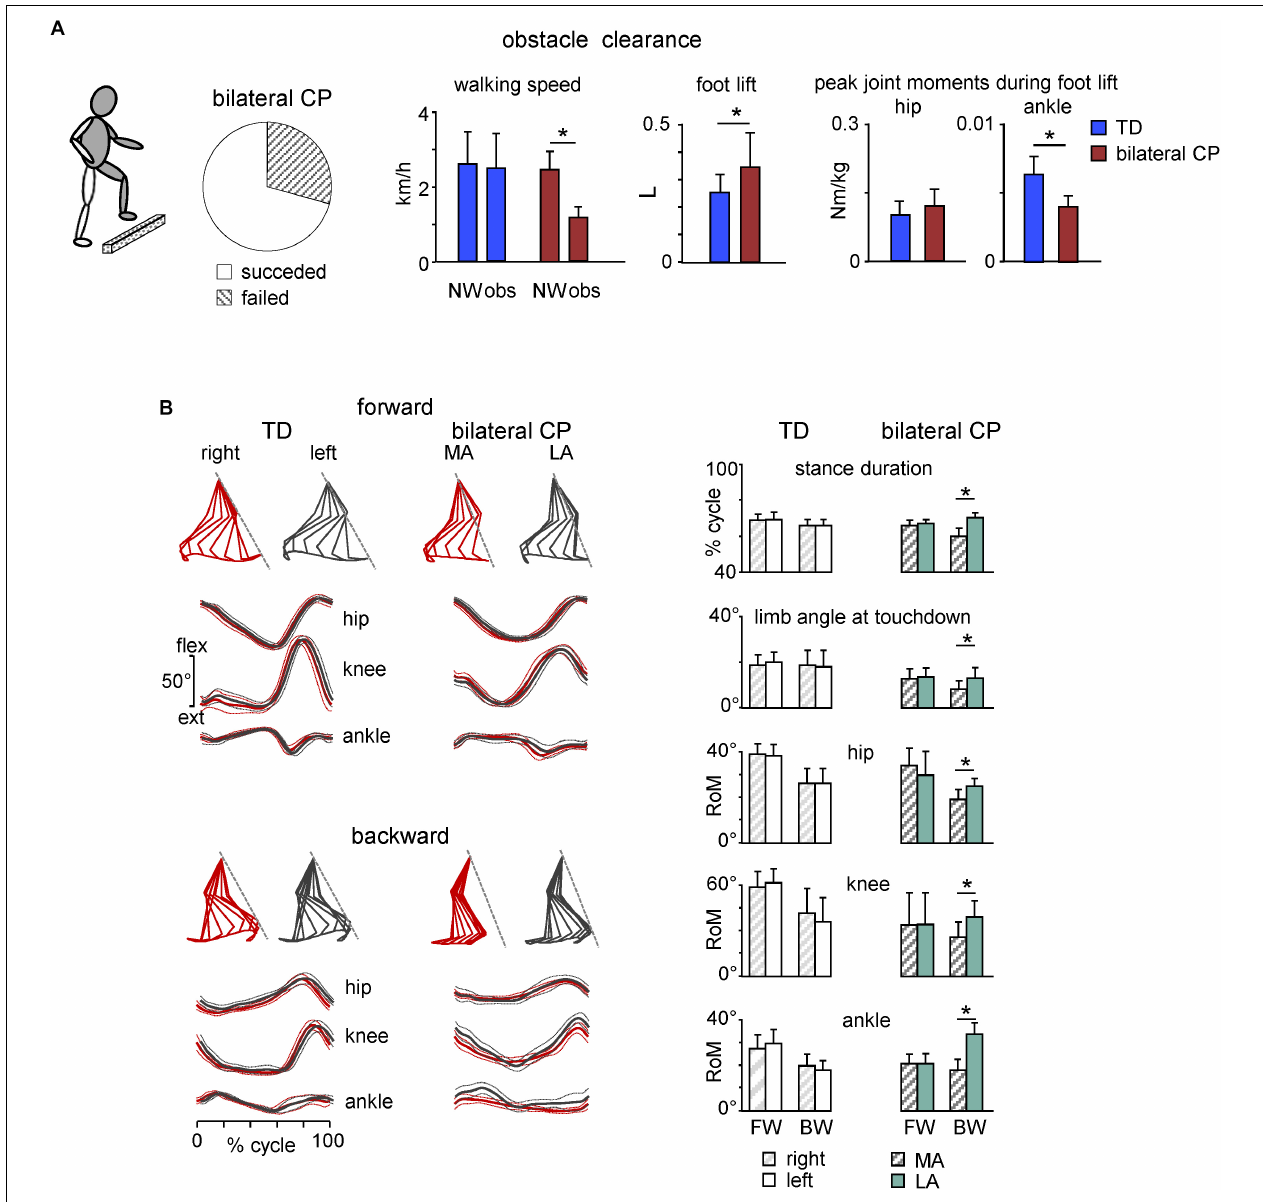
FIGURE 5 | Adaptive locomotion in children with CP. (A) Obstacle task performance in children with bilateral CP. From left to right: pie chart showing the percentage of trials for children with succeeded and failed obstacle clearance, mean (+SD) walking speed for successful trials, foot lift and flexor peak hip and ankle muscle moments during trailing limb elevation. Asterisks denote significant side differences. Adapted from Cappellini et al. (2020). (B) Kinematics of forward and backward walking in TD and children with bilateral CP. Left panels: examples of forward gait kinematics in one TD child (5.7 years) and one child with CP (6.1 years) during forward and backward walking. From top to bottom: stick diagrams of the swing phase of a single step for both legs (relative to the instantaneous hip position), and ensemble-averaged (across all strides, ± SD) hip, knee, and ankle joint angles (red corresponds to the most affected side in CP). Dashed lines in stick diagrams correspond to the orientation of the left (in TD) and least affected (in CP) limb during touchdown. Right panels: comparison of gait parameters and ranges of angular motion (+SD) for both legs in TD and children with bilateral CP during forward (FW) and backward (BW) walking. MA, most affected; LA, least affected side. Adapted from Cappellini et al.